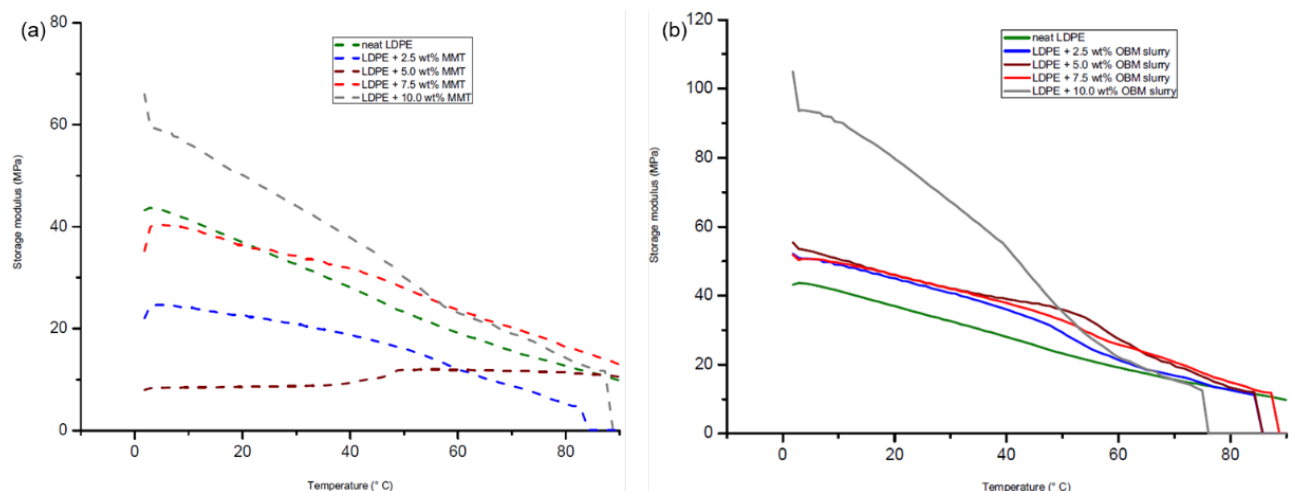
Figure 16. Influence of applied shear stress on the storage modulus of ( a ) neat LDPE and LDPE/MMT and ( b ) neat LDPE and LDPE/OBM slurry nanocomposites.